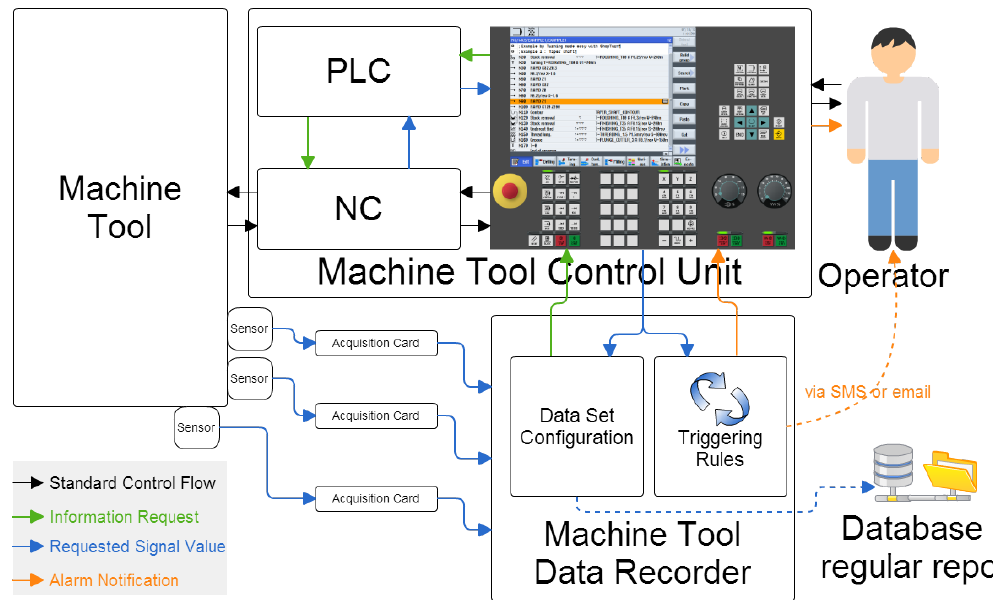
Figure 2. Data acquisition platform flows and